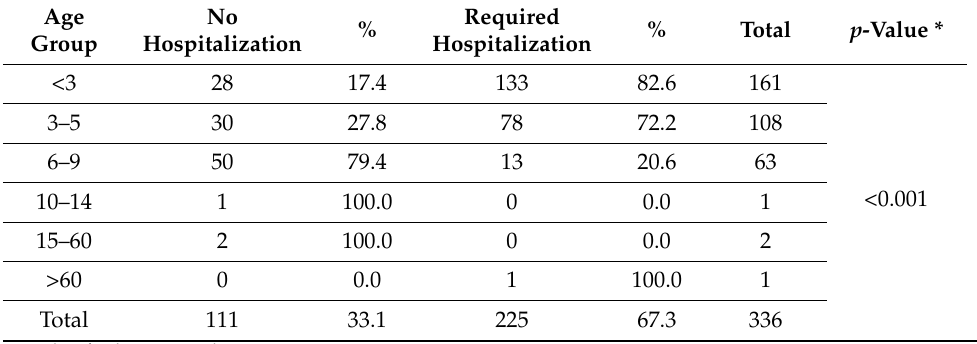
Table 4. The frequency of hospitalization due to RSV infection in different age